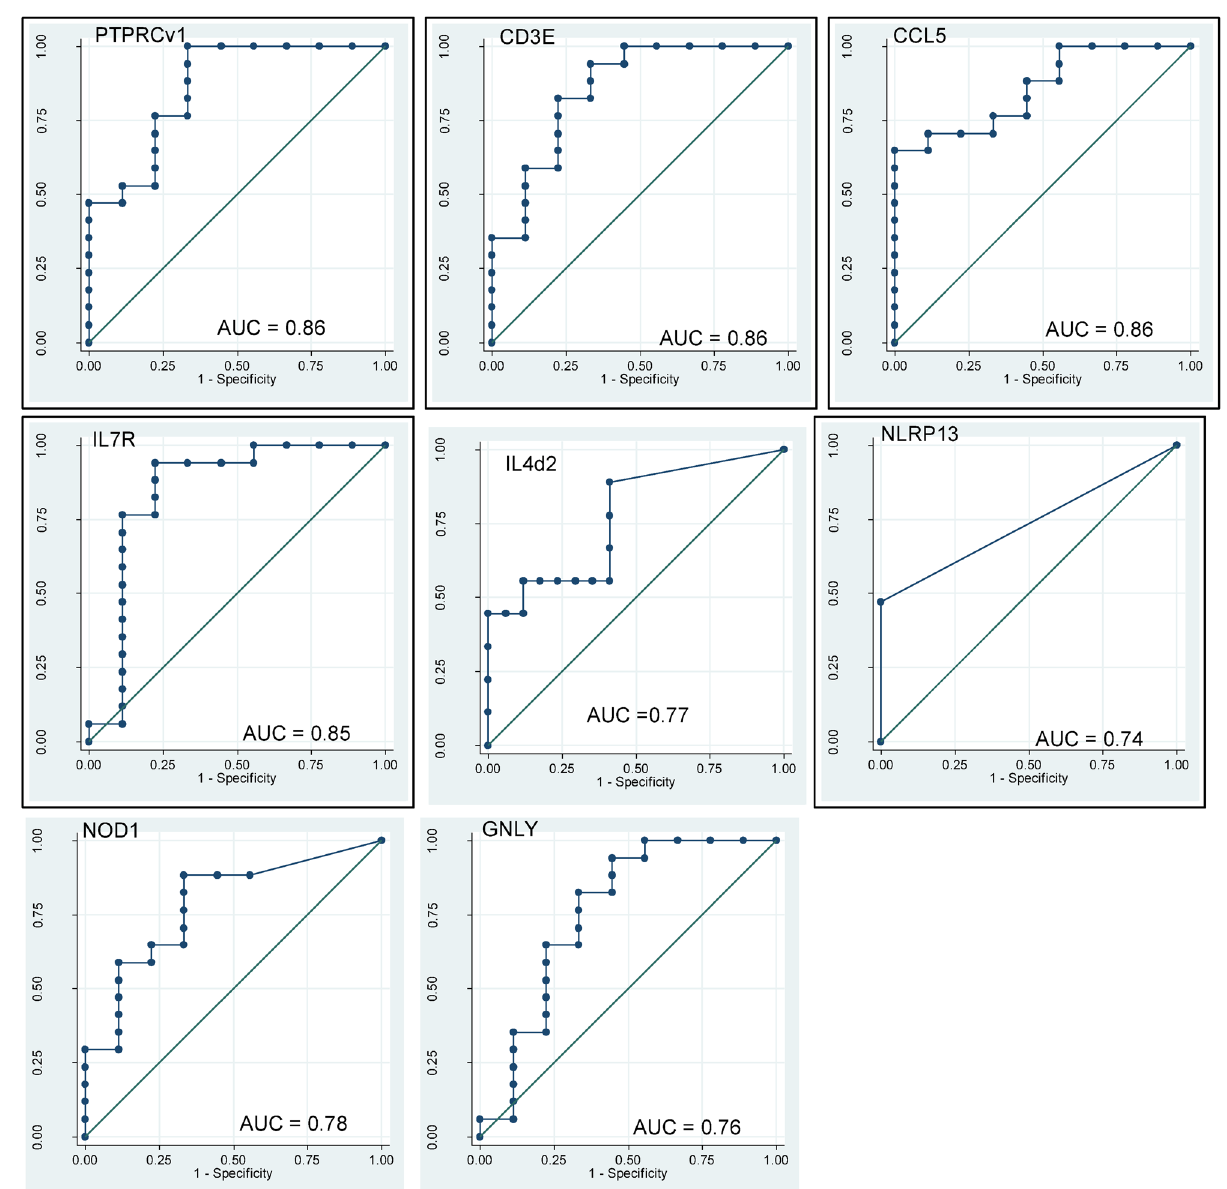
Figure 2. Single host genes with discriminatory power to classify death groups from survived groups. Receiver operator characteristics (ROC) curves showing the accuracies of individual genes in discriminating death groups versus survival groups. AUC Area under the